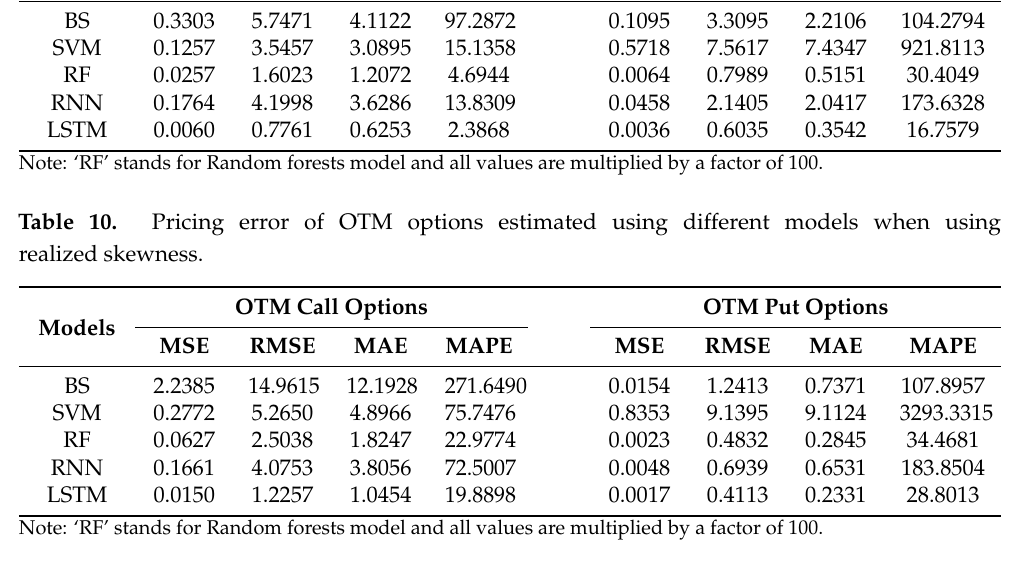
Table 9. Pricing error of ATM options estimated using different models when using realized skewness. Models